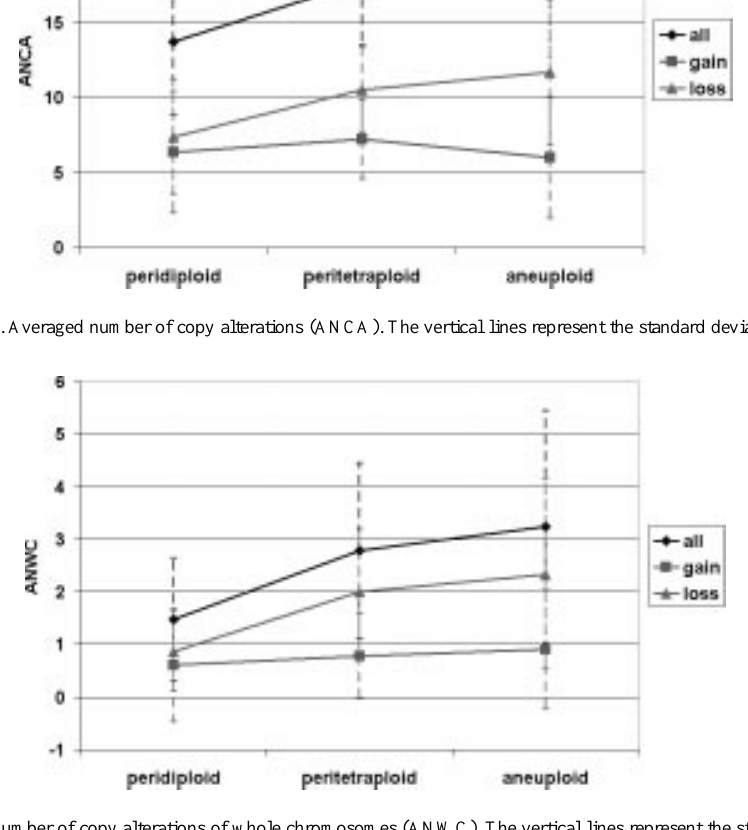
Fig. 2. Averaged number of copy alterations of whole chromosomes (ANWC). The vertical lines represent the standard deviations.